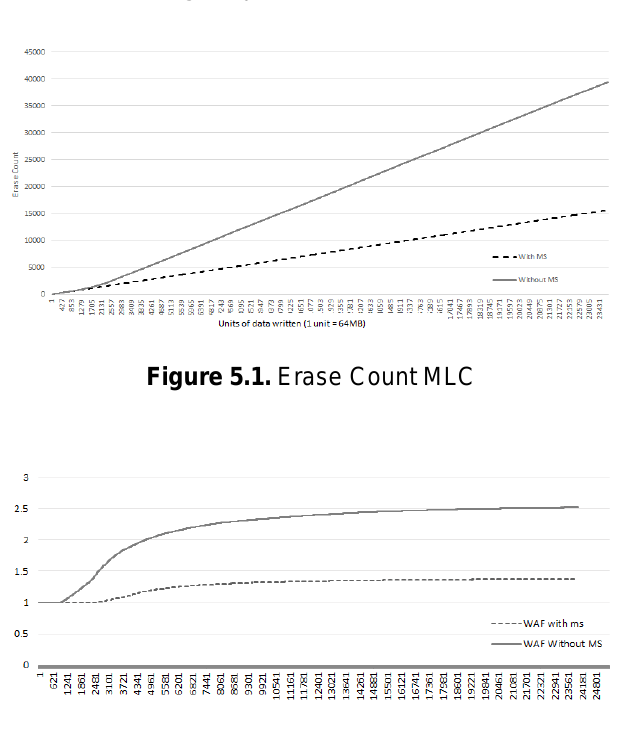
Figure 5.2. Write Amplification